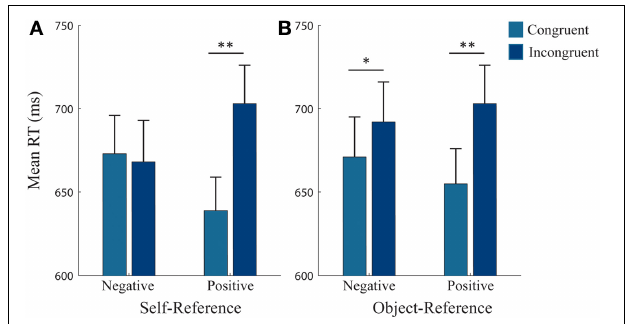
FIGURE 3 | RTs for each reference condition, collapsed across movement type. Mean reaction times (RTs) for each reference-frame collapsed across pull and push movements. (A) Self-reference condition: RTs were significantly faster when participants approached compared to avoided positive pictures. (B) Object-reference condition: RTs were significantly faster for approaching than avoiding positive pictures and marginally significantly faster when avoiding compared to approaching negative pictures. Error bars ( + 1 SE); light blue bars, congruent; dark blue bars, incongruent. ∗∗ , significant at < 0.001 level; ∗ , marginally significant ( p = 0 .